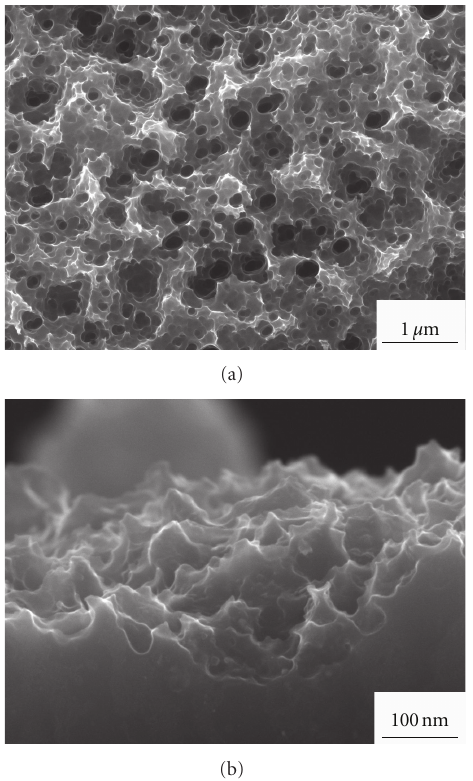
Figure 1: The microstructure of the black silicon produced by PIII (a) top view and (b) cross-sectional view of the black silicon.